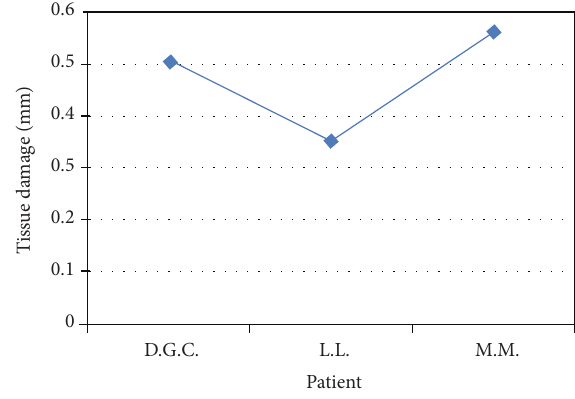
Figure 8: Representation of peri-incisional marginal damage in oral lichen